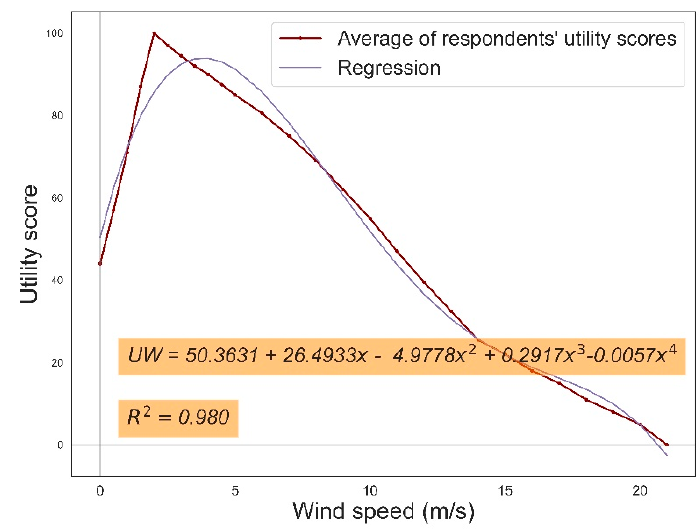
Figure 11. Empirical utility function for wind in urban tourism.